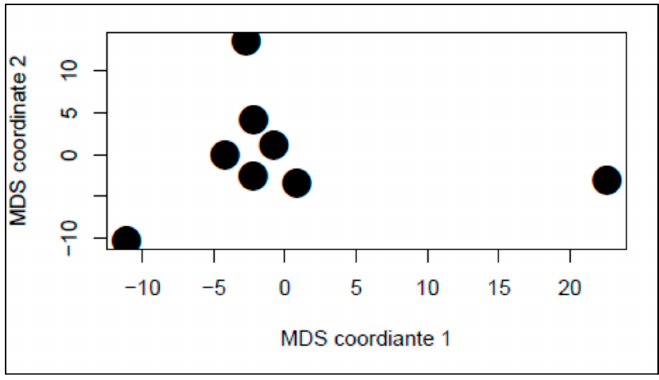
( b ) Group 2. Number of animals = 12. Figure 2. The Multi-Dimensional Scaling (MDS) projection based on the Hamming distances of agonistic behaviour patterns between networks (pens) with the same number of animals, ( a ) Group 1, includes 11 pens with 11 animals each and ( b ) Group 2, includes 8 pens with 12 animals each.